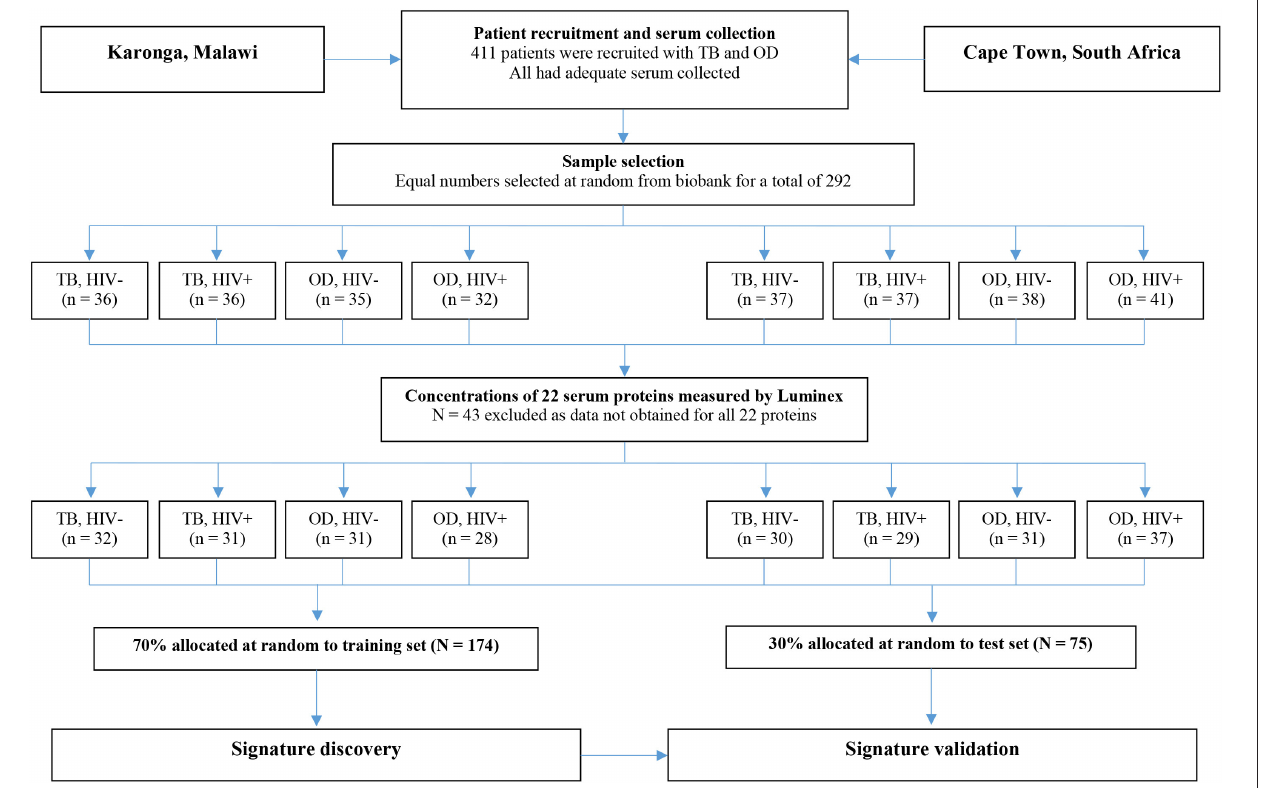
as the mean of the coefficients of variance for each analyte individually across all plates, was < 12% for all proteins. Results value of zero. If above the upper limit, they were retested at a higher